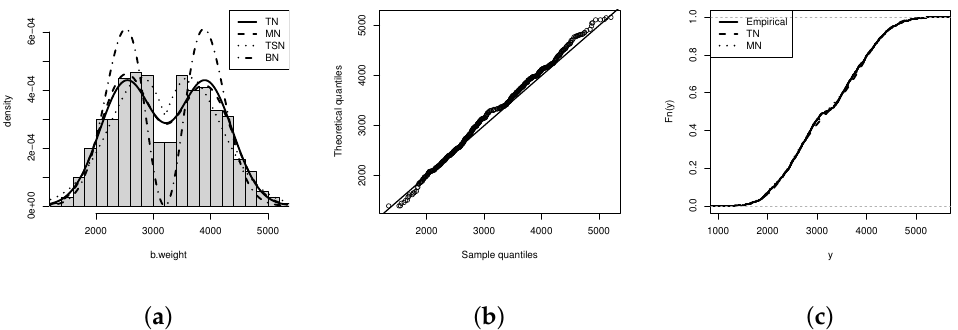
Figure 3. ( a ) Histogram of ultrasound weight variable and models fitted with the MLEs for TN, MN, TSN, and BN, respectively. ( b ) qq-plot for the TN model. ( c ) Empirical CDF and CDFs of the MN and TN